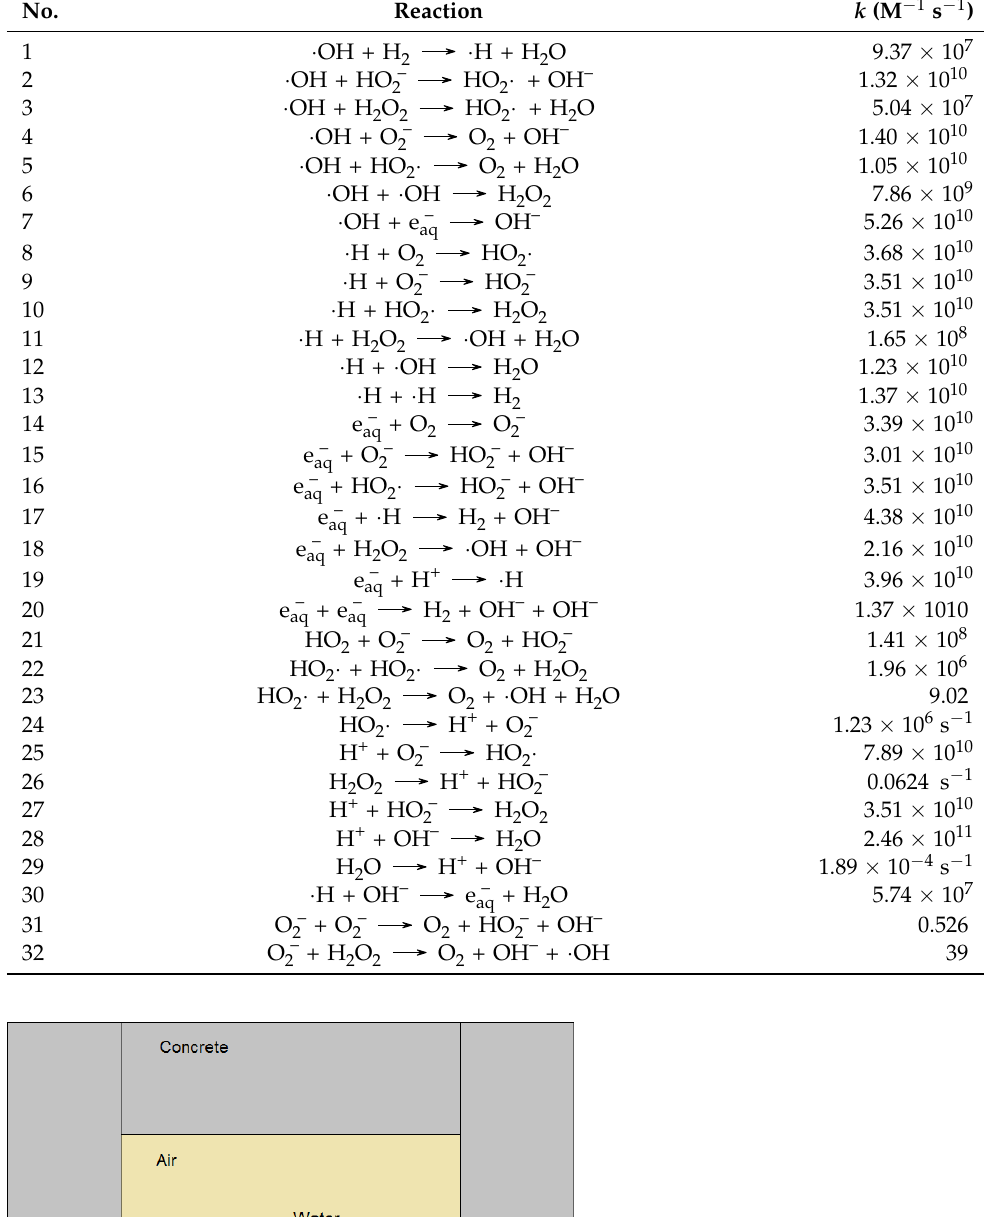
Table 1. Reactions, rate constants, and activation energies used in the model (adapted from [10]). No.